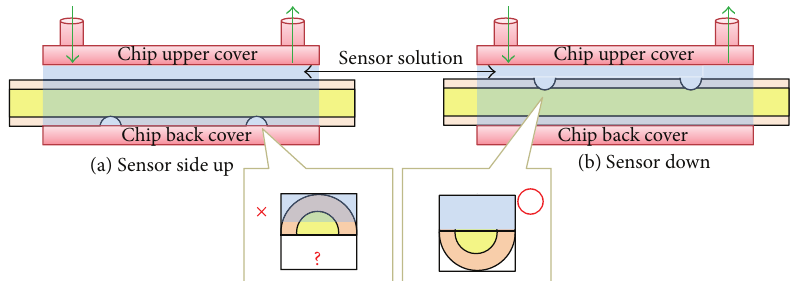
Figure 11: Influence of the linear fluidic channel chip.